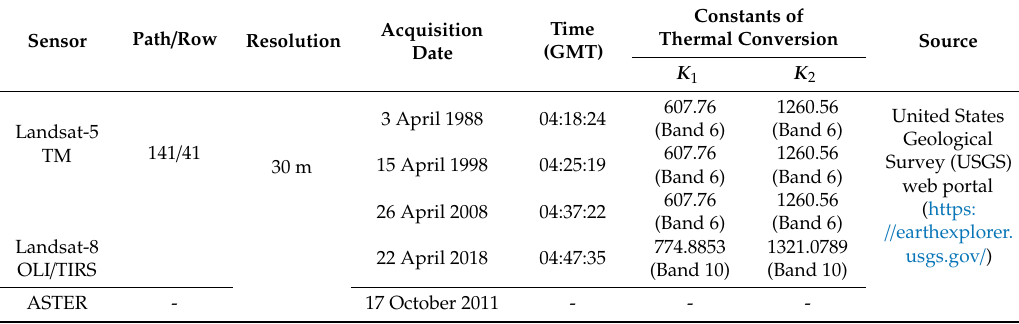
Table 1. Description of the Landsat datasets used for the study area, Kathmandu